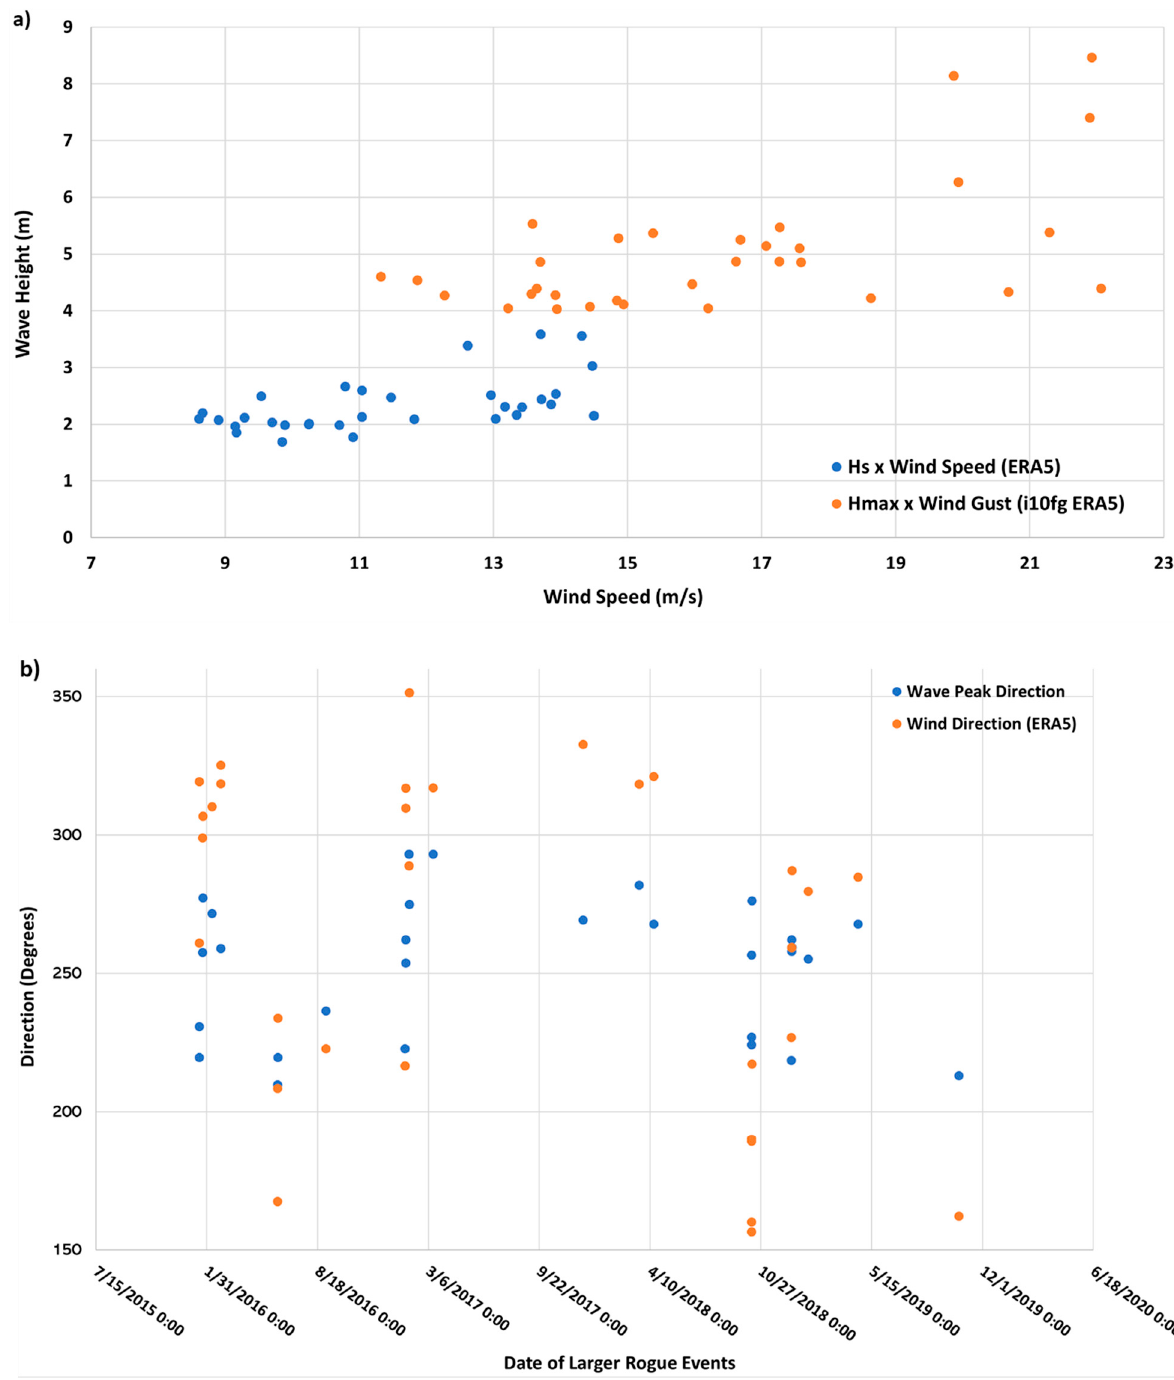
Figure 11. ( a ) Wind speed compared to rogue wave height, with H s versus U 10 (wind speed at 10 m) data from ERA5 in blue and H max versus wind gust (at 10 m) data from ERA5 in orange (2015 to 2019); ( b ) wind direction data from ERA5 at 10 m compared to rogue wave peak direction during the same period.